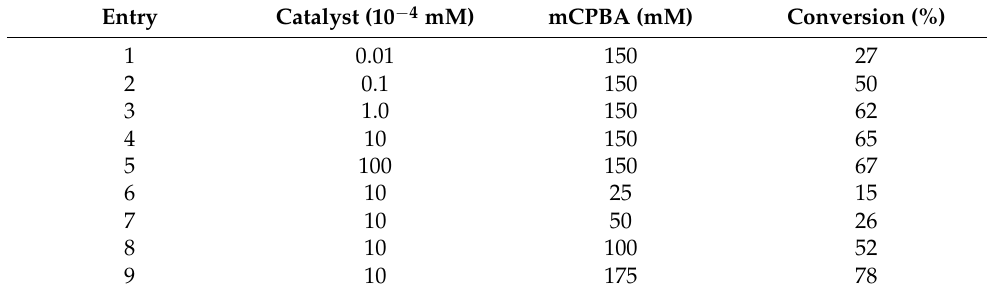
Table 5. Dependence between the conversion and number of turnover values on the catalyst ( 2 ) and mCPBA concentrations for the iron(II)-catalyzed Baeyer–Villiger oxidation of cyclohexanone by mCPBA 1 .